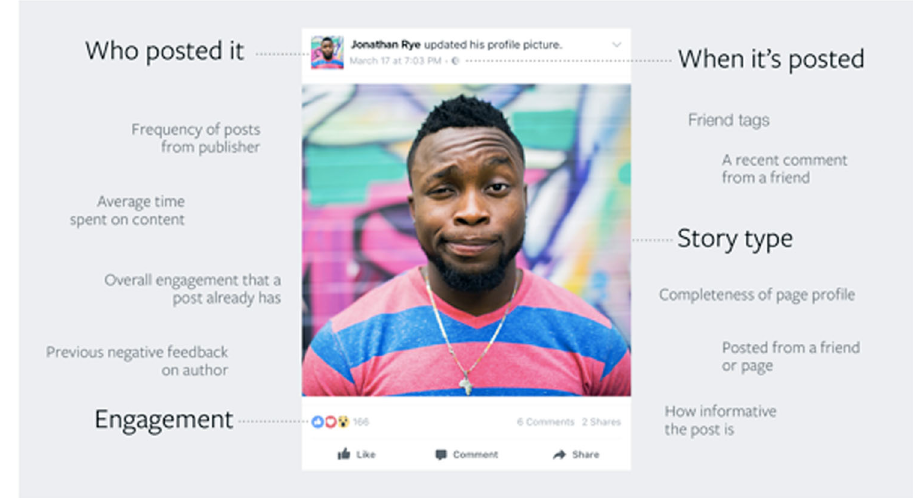
Fig. 2 News Criteria. Screenshot of Facebook page listing some of the criteria used by its News